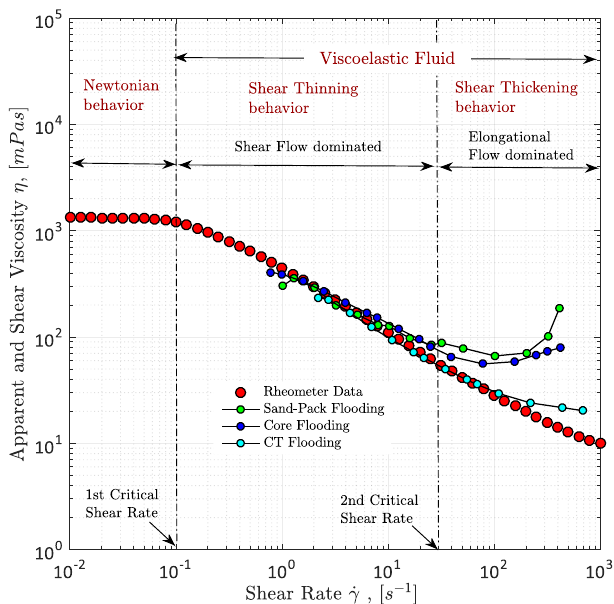
Figure 5. Viscoelastic flow behavior illustrated in a shear rate vs. apparent/shear viscosity plot.